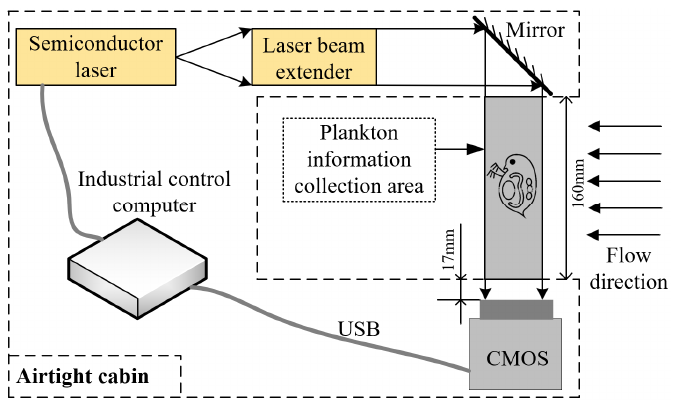
Figure 2. Schematic diagram of the Seascan in-line digital holographic system.